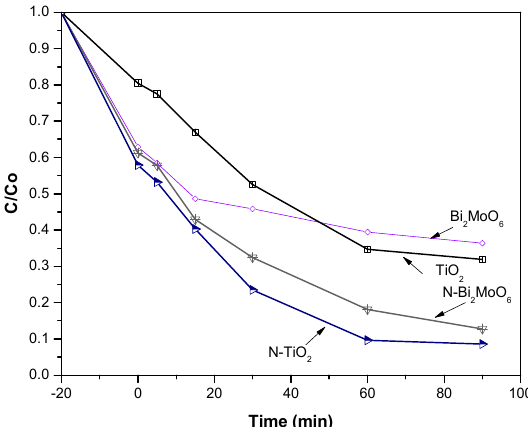
Figure 8. Lignin degradation in presence of TiO 2 , N-TiO 2 , Bi 2 MoO 6 , and N-Bi 2 MoO 6 catalysts under ultraviolet (UV) energy irradiation.